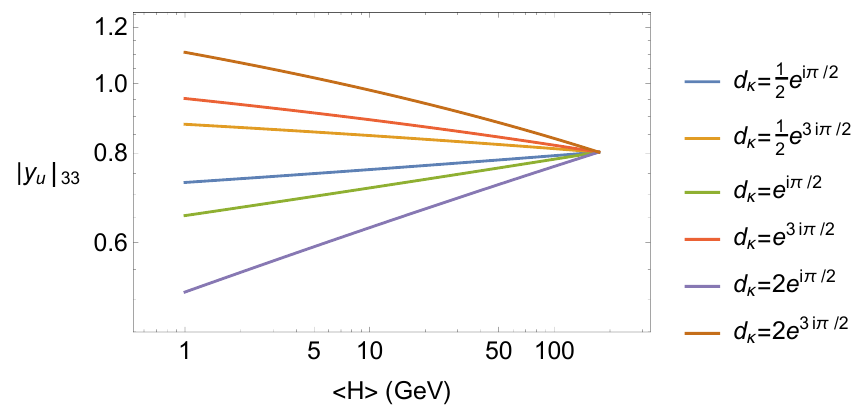
~ (cid:21) u given by eq. (6.3), as a function of the !